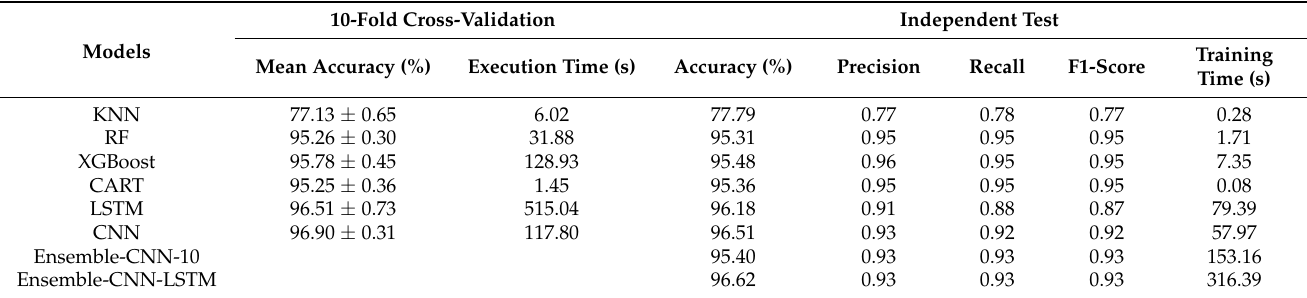
Table 7. Performance metrics for multi-attack classification for 10-fold cross-validation with variance and independent test.